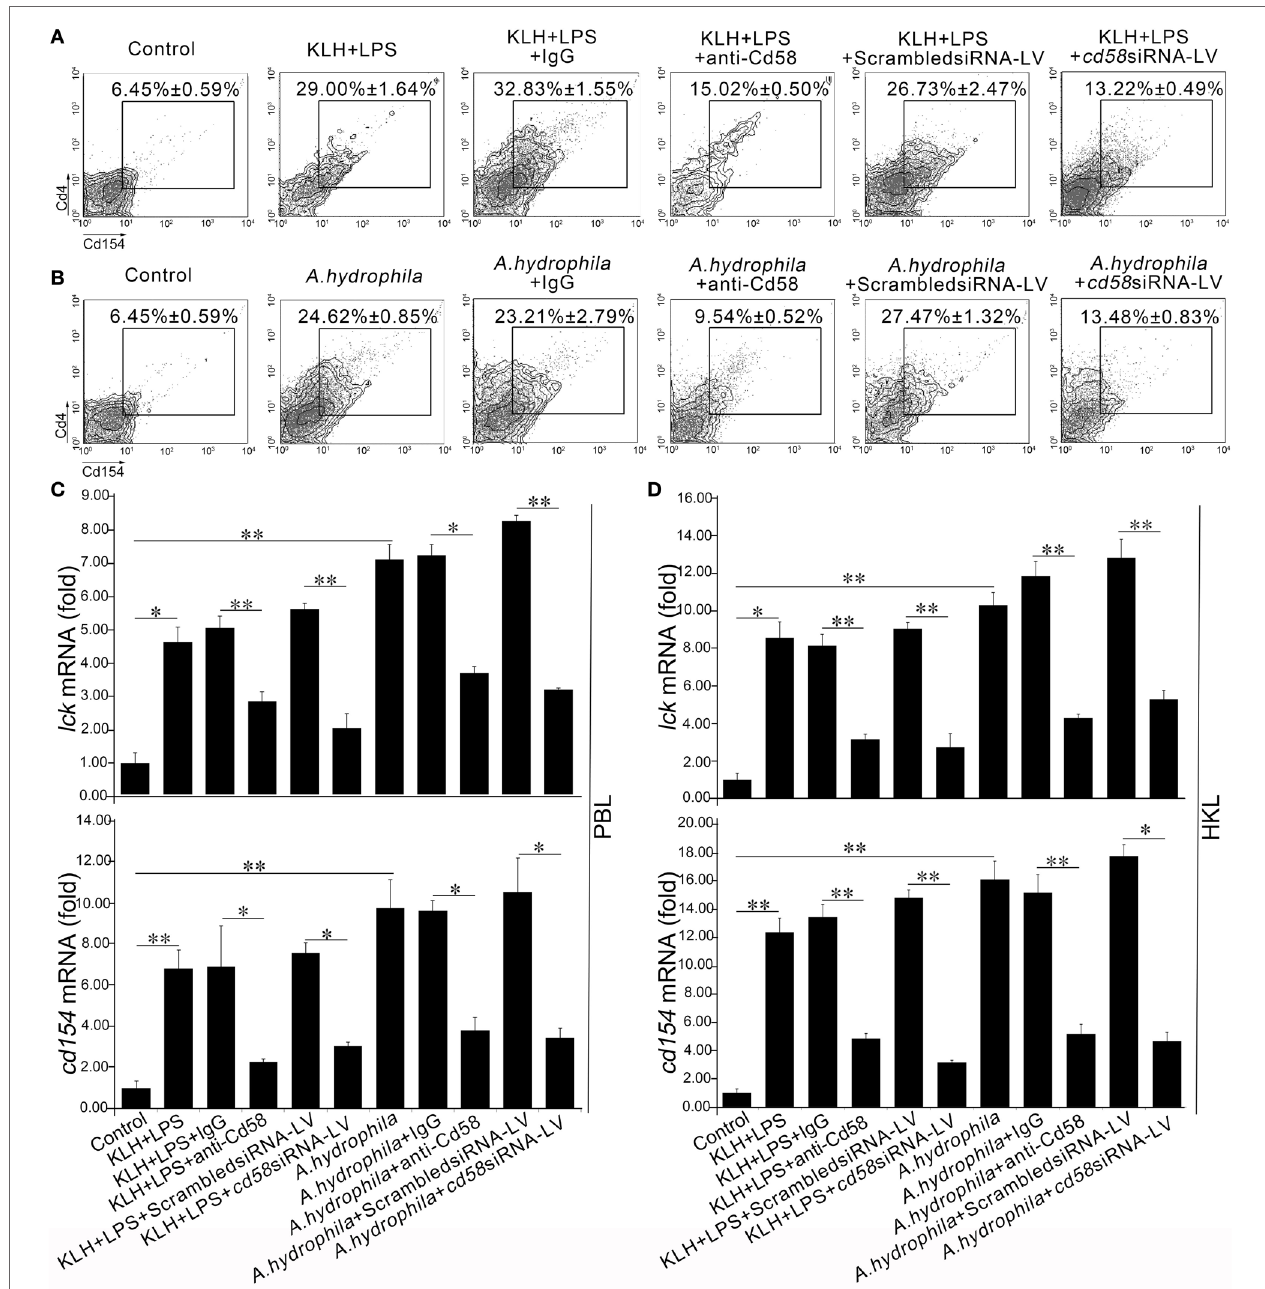
FigUre 8 | In vivo evaluation of Cd58 in Cd4 + T cell activation. The degree of Cd4 + T cell activation is represented by the percentage of Cd4 + Cd154 + T cells determined by flow cytometry (a,B) and by the expression levels of lck and cd154 genes detected by real-time PCR (c,D) . In the flow cytometric analysis, different treatments were presented at the top of each block diagram. The numbers adjacent to the outlined areas indicate the percentage of Cd4 + Cd154 + cells in each treatment group. In the real-time PCR assay, PCRs were run in combination with the endogenous β -actin control. Error bars represent SE. All data are from at least three independent experiments (* p < 0.05, ** p <